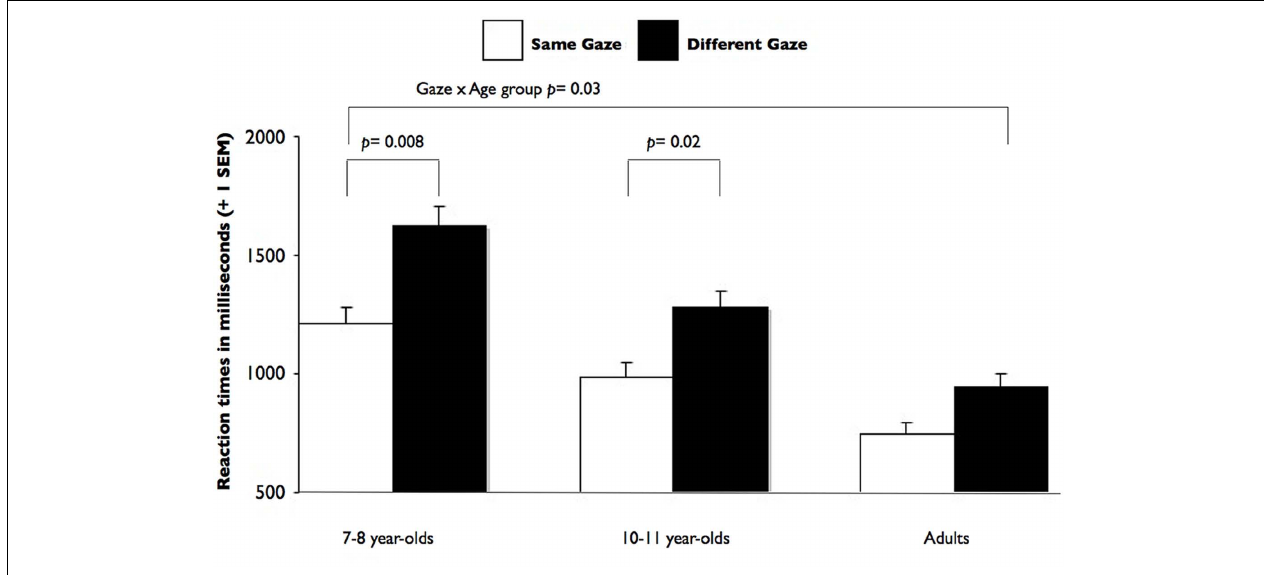
FIGURE 6 | Experiment 2: two-way interaction for gaze × age group in the reaction times. Further decompositions showed that this interaction was driven by increased reaction times for a detection of a change in gaze in the two children groups.